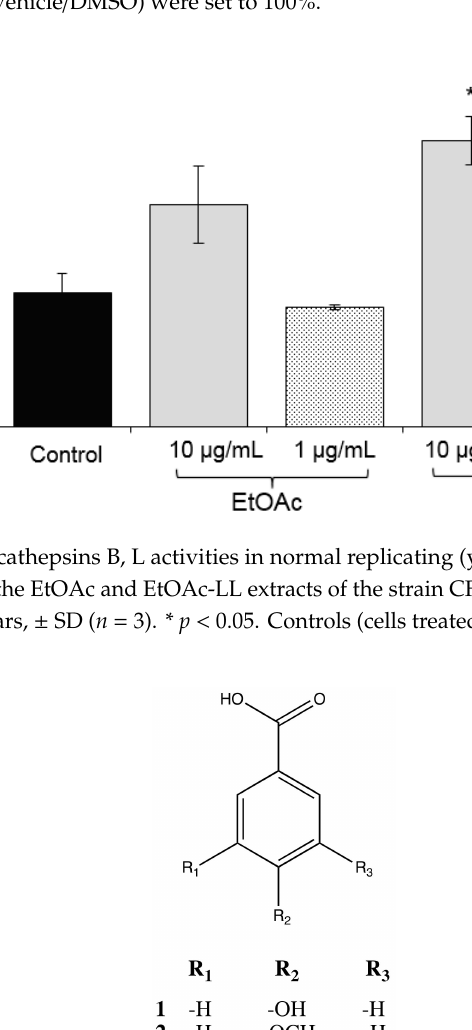
Figure 1. Relative (%) 26S proteasome activities of CT-L (LLVY / β 5) and C-L (LLE / β 1) in normal replicating (young) human fibroblasts after 24 h of treatment with the EtOAc and EtOAc-LL extracts of the strain CF-092983 at concentrations of 10 µ g / mL and 1 µ g / mL. Bars, ± SD ( n = 3). * p < 0.05. Controls (cells treated with the vehicle / DMSO) were set to 100%.